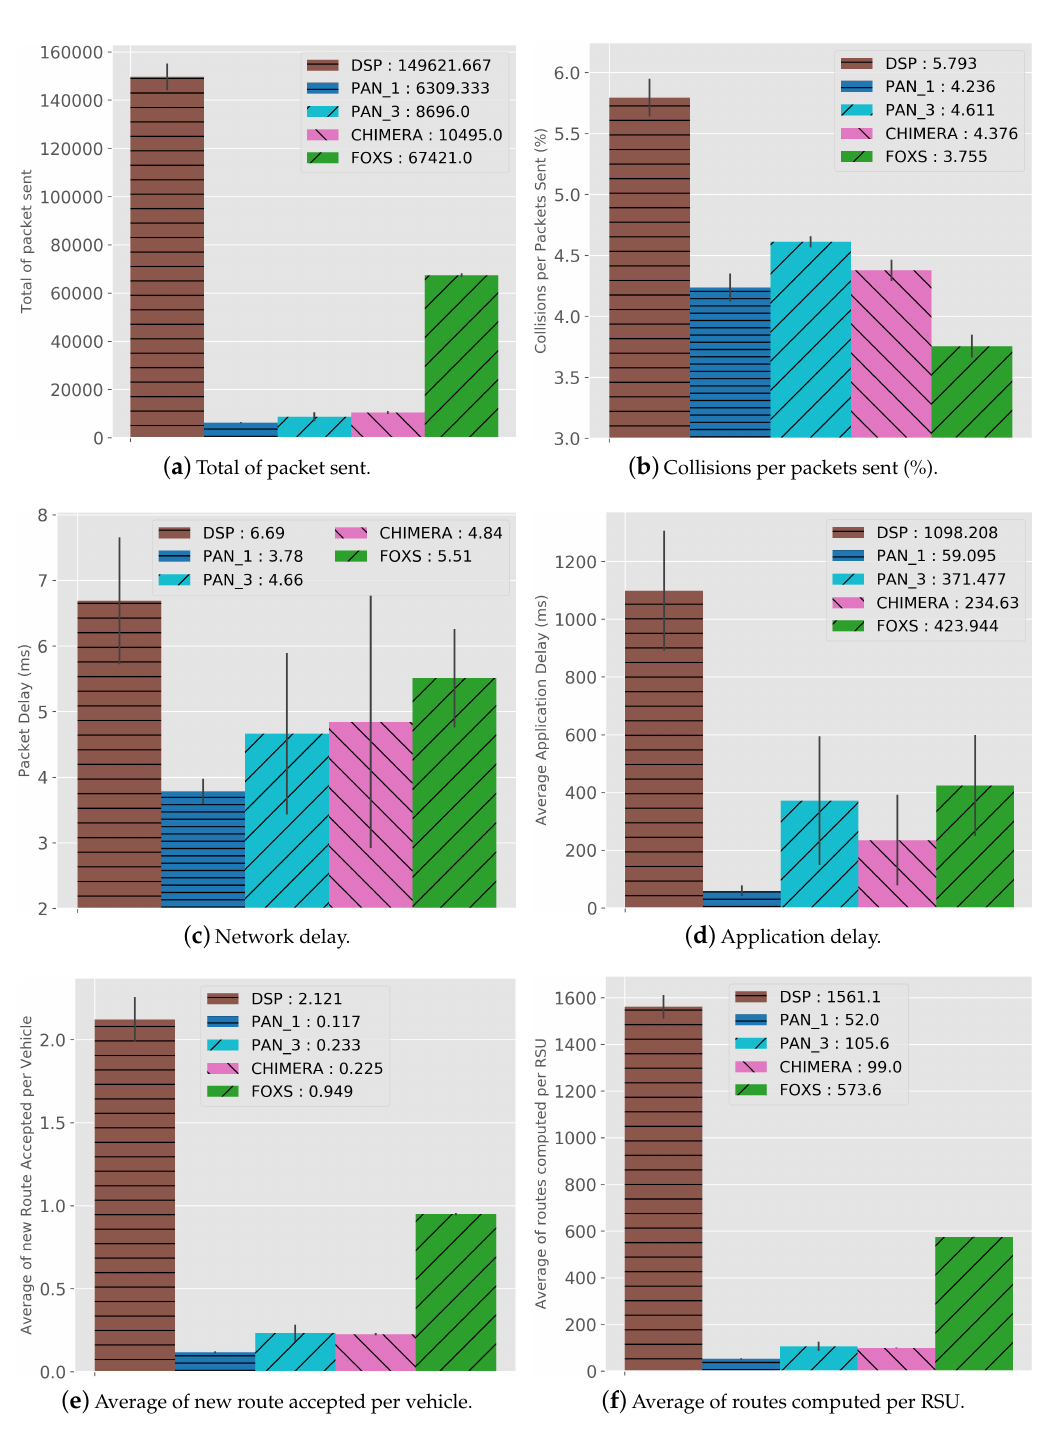
Figure 22. Network Cost Results—Cologne